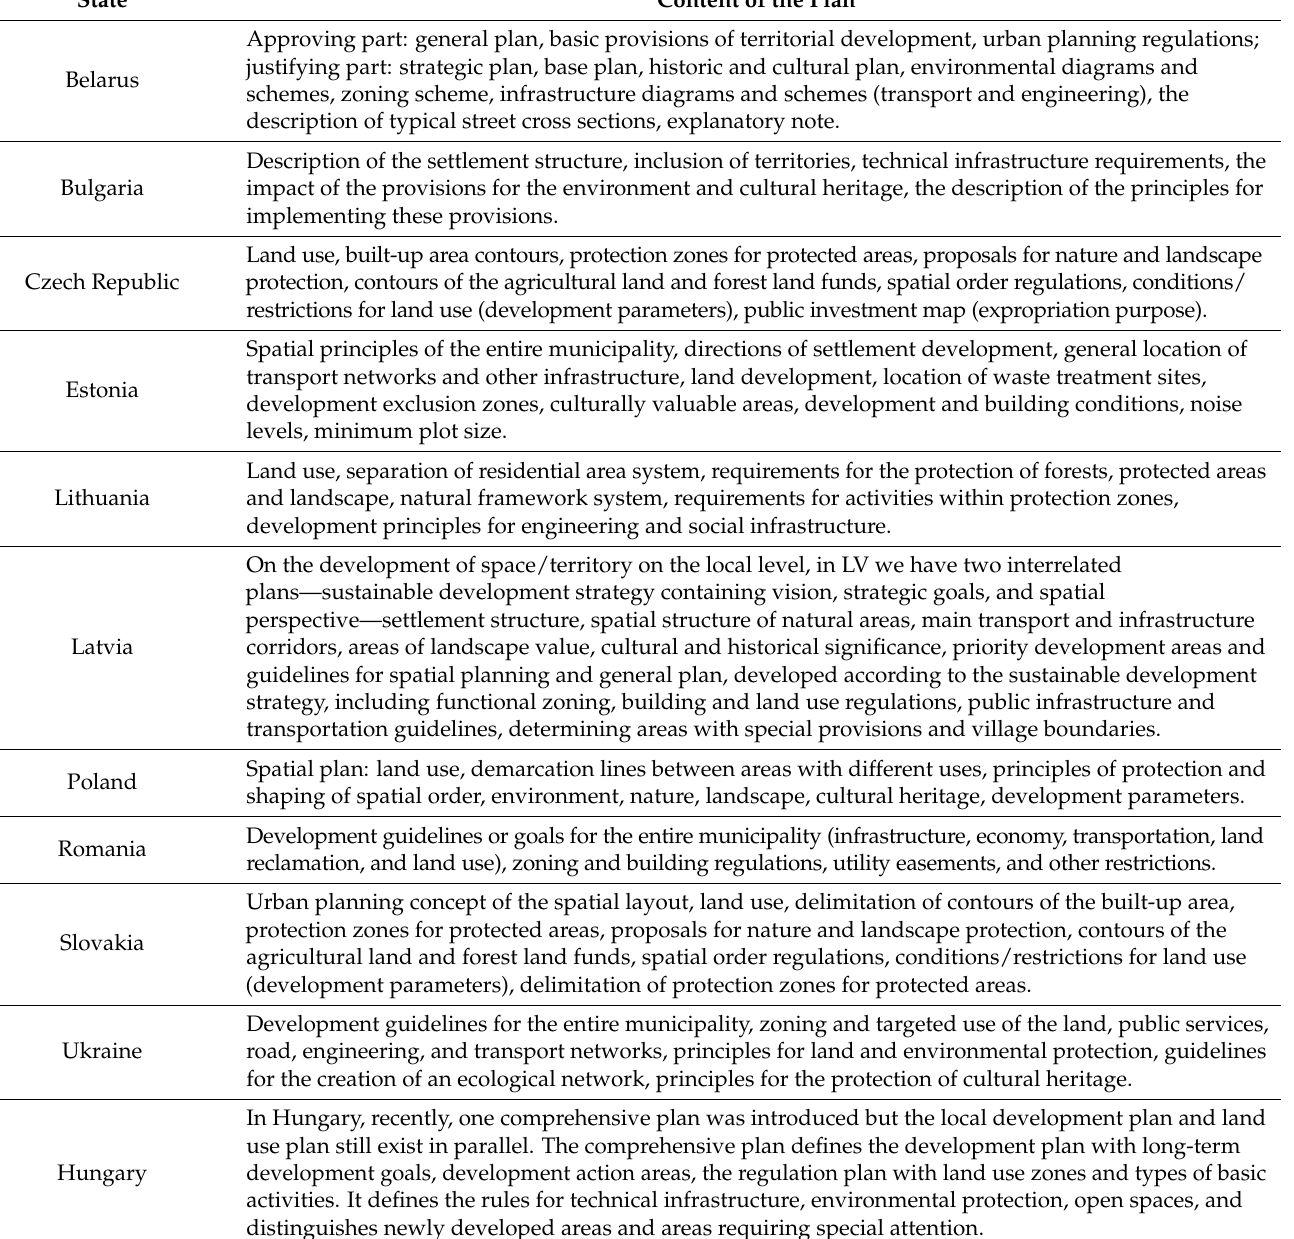
Table 5. Content of general plans at the local